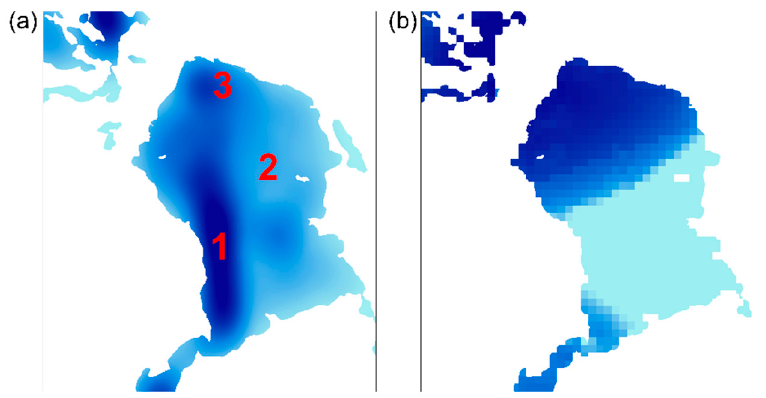
Figure 5. Internal diversity of boat density within Ś niardwy lake: ( a ) based on map derived from Sentinel-1 images and ( b ) based on map derived from field observations. 1—main sailing trail, 2— stone reefs.